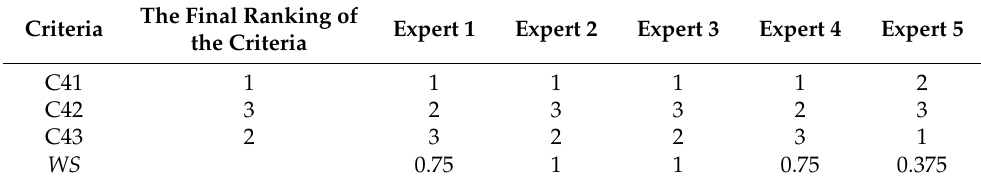
Table 11. The WS coefficients of the sub-criteria of